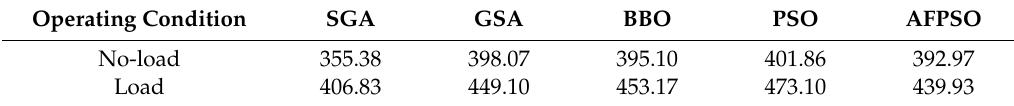
Table 9. Computational expense of di ff erent algorithms under the two operating